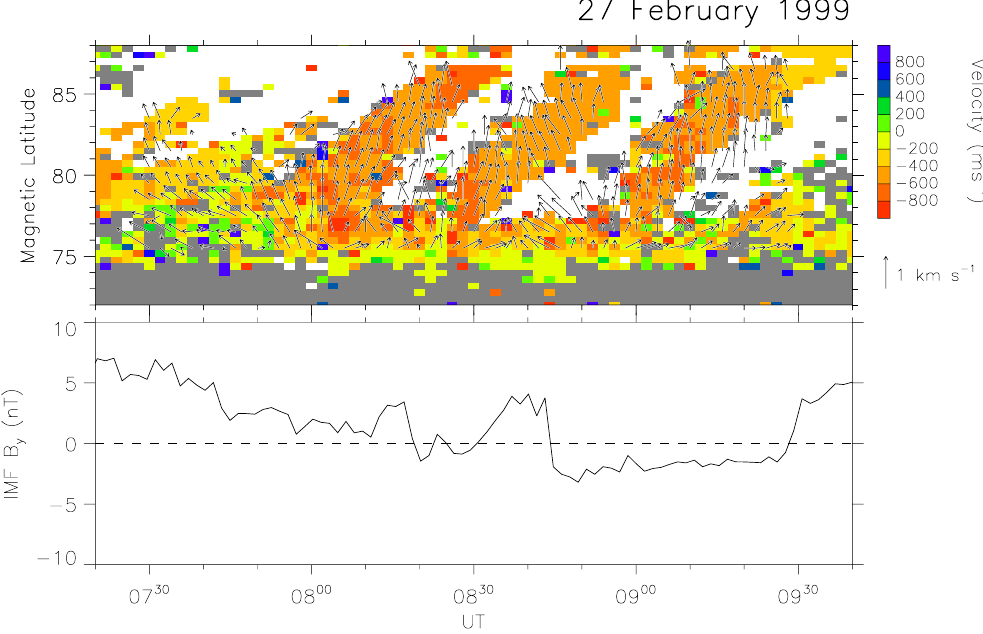
Fig. 3. An expanded view of the plasma drift latitude-time plot of Fig. 2, along with the B Y component of the IMF. Vectors calculated with a beam-swinging technique are superimposed on the plasma drift velocities. Vectors pointing towards the top and right of the panel indicate flow directed northwards and eastwards,